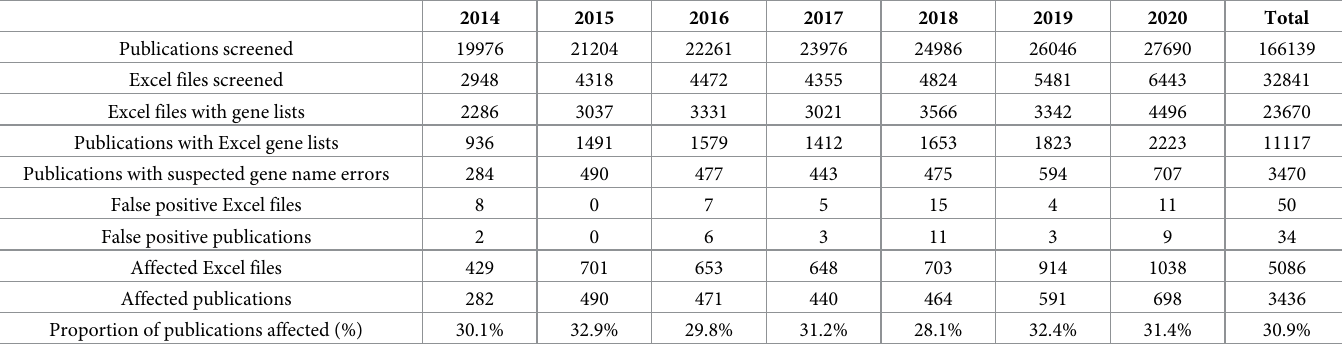
Table 3. Results of a screen for gene name errors in